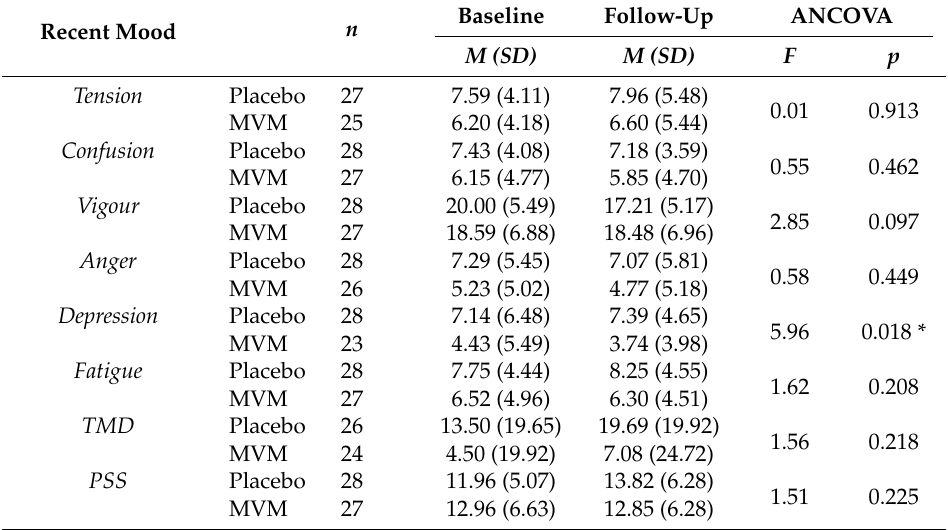
Table 4. Measures of recent mood at baseline and follow-up for MVM and placebo treatment groups. Baseline Follow-Up Recent Mood n